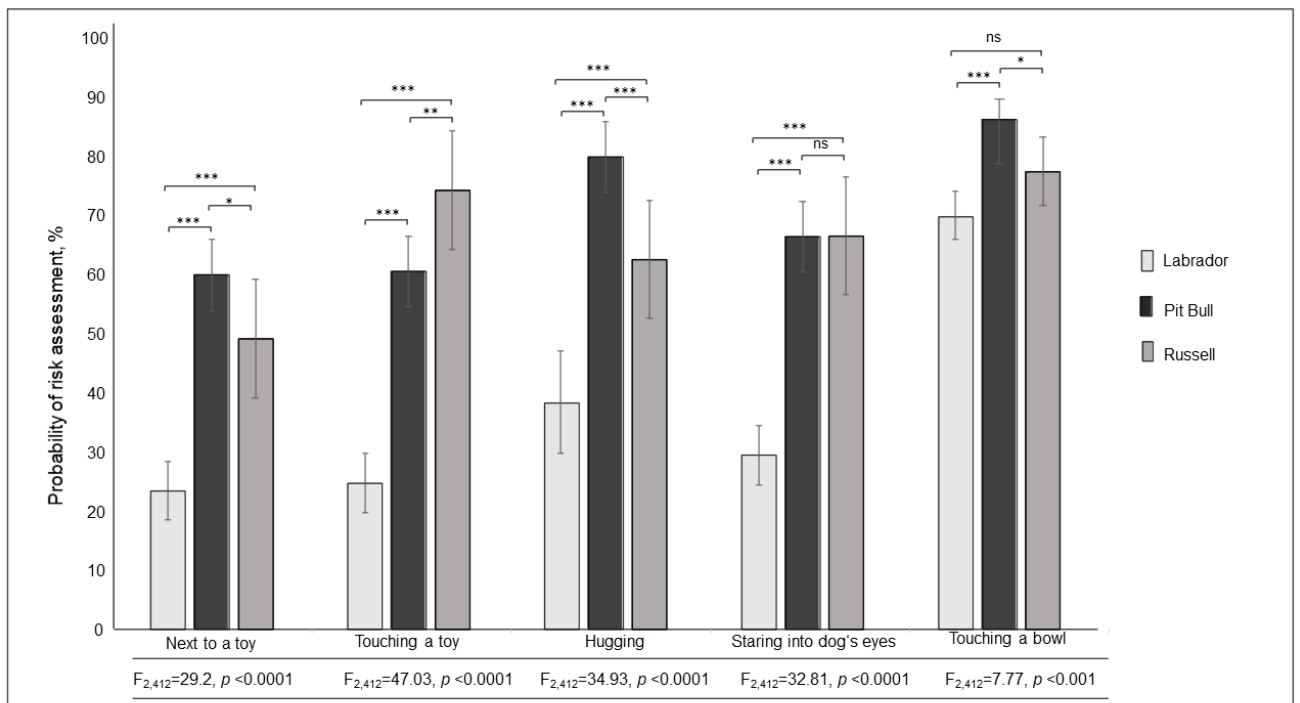
Figure 2. Differences between probability of risky situation assessment in the photo-set of all dogs.